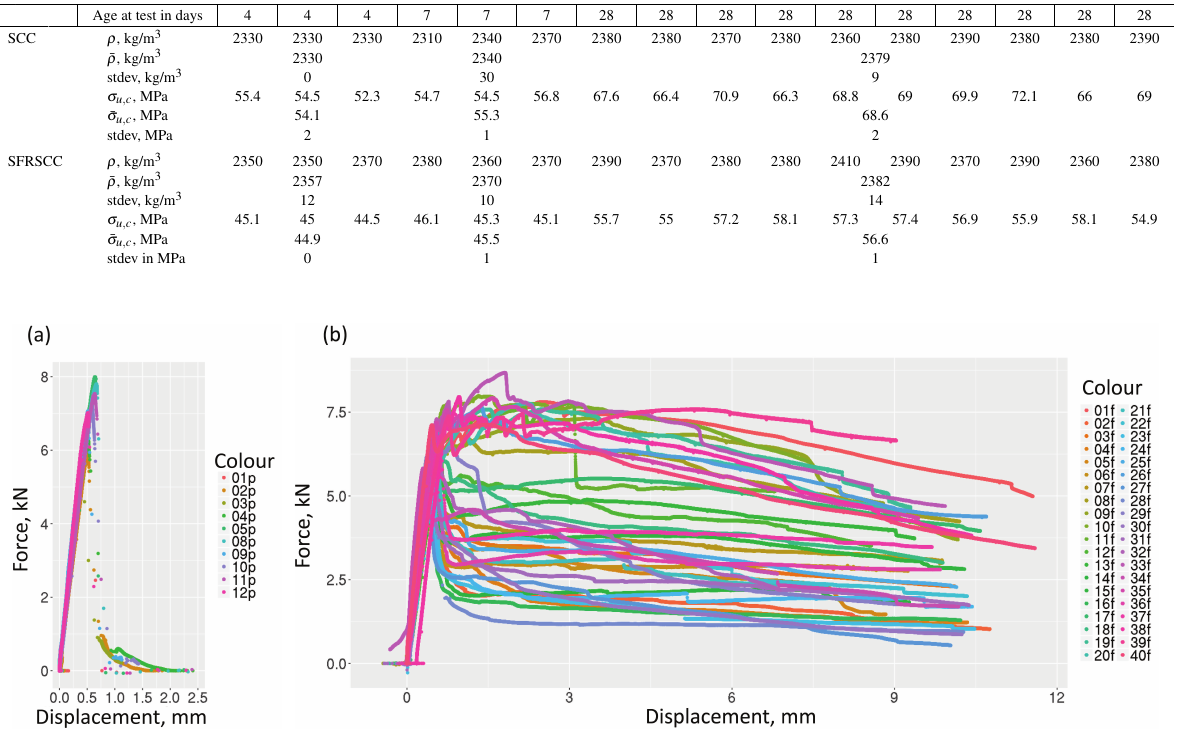
Fig. 7. Load-displacement diagrams for the tested beams: (a) SCC, (b)